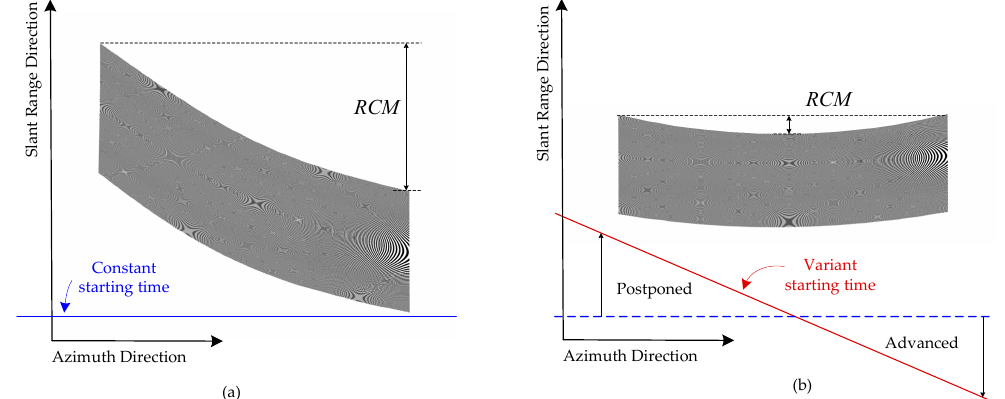
Figure 7. Effect of a variable starting time for the receive window. ( a ) The echo acquired by the squint mode with a constant starting time for the receive window represented by the blue line. ( b ) The echo acquired using the same mode but with a starting time that varies according to the red line, where the starting time is postponed during the first half of data recording and is advanced during the latter